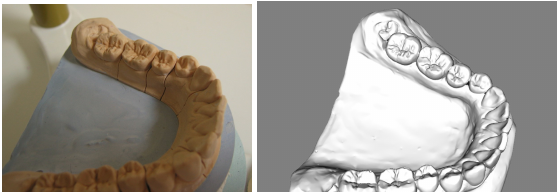
Figure 1. Stone cast model of the lower dental arch (left) and its 3D image (right)